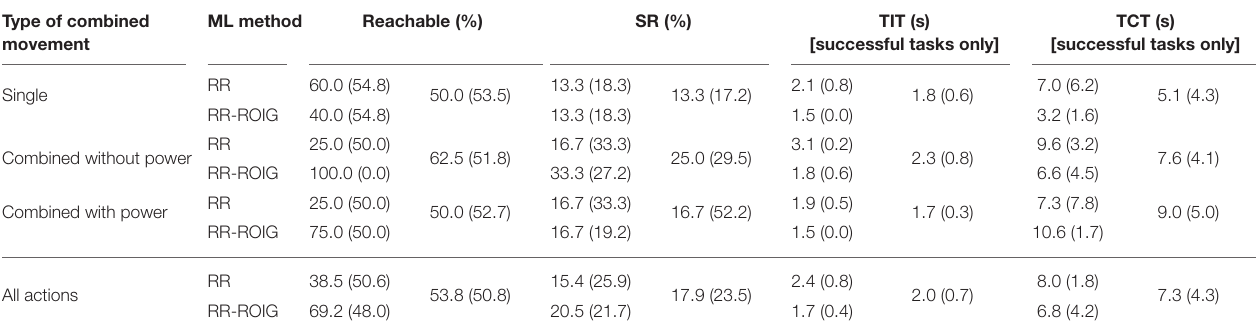
TABLE 3 | Means and standard deviations of the reachability of the tasks, the success rate, the time in task and the time to complete the successful tasks for the amputee according to the type of combined movement.